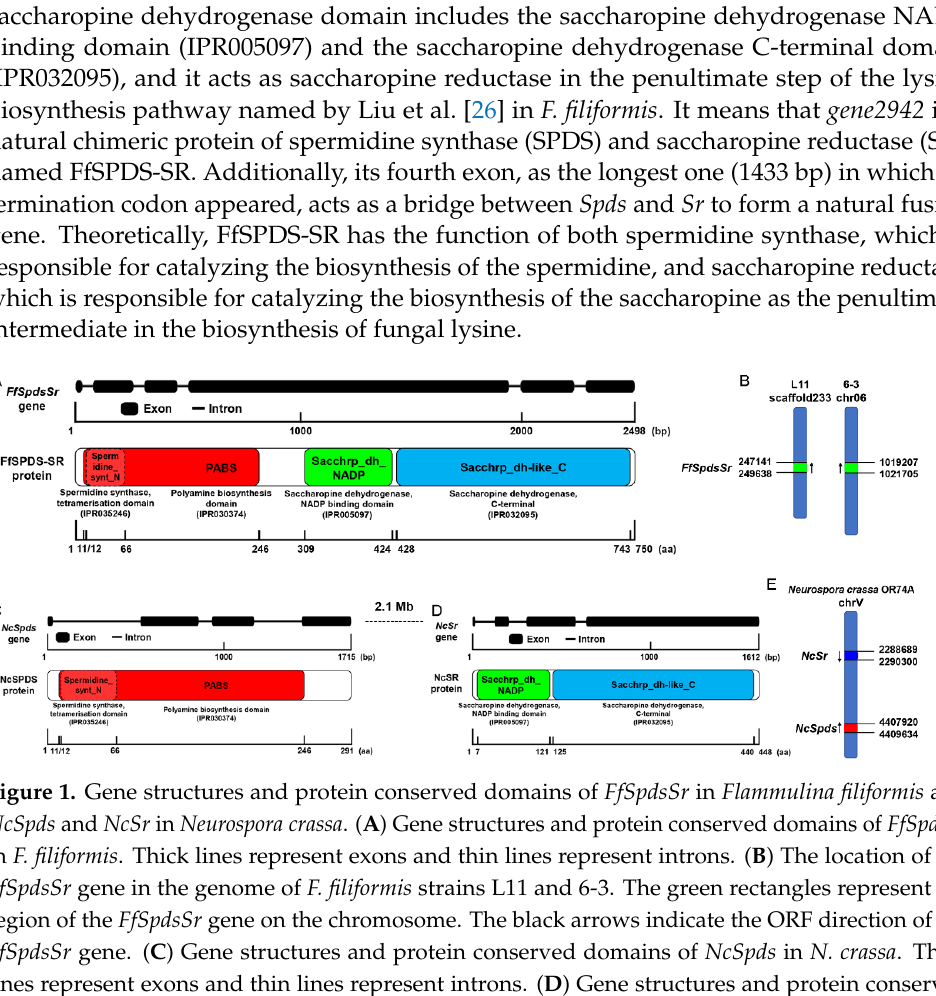
genome of F. filiformis strain L11 (Figure 1B). The unique copy of chimeric FfSpdsSr also